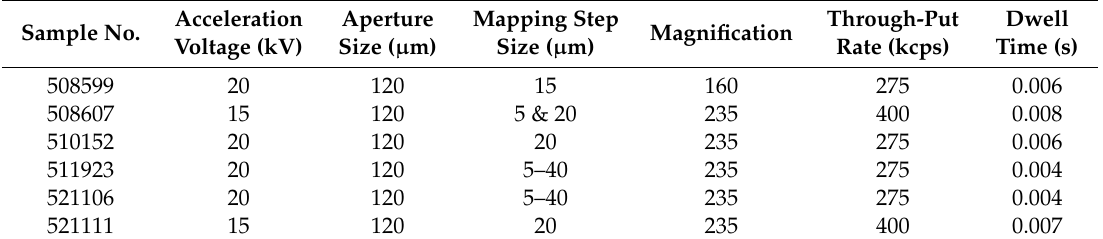
Table 1. Analytical conditions for Mineral mapping. Mapping step size: three samples were mapped several times at di ff erent step sizes, see Section 3 (Examples of Applications) for details. Sample